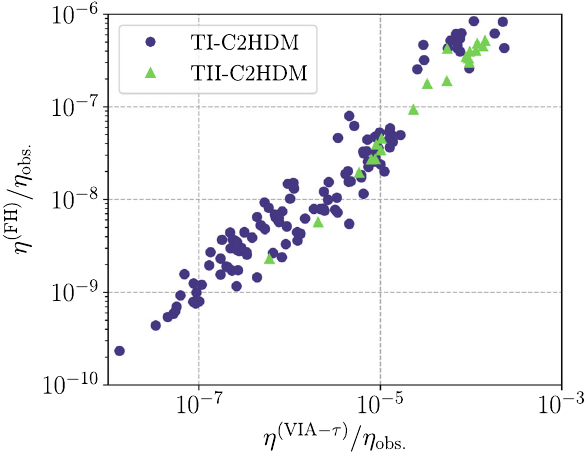
Fig. 3 BAUs in the FH approach versus the VIA approach, including t , b and τ contributions in the latter, both normalised to the observed value. Results for the C2HDM TI are shown as violet points, those for the C2HDM TII as green